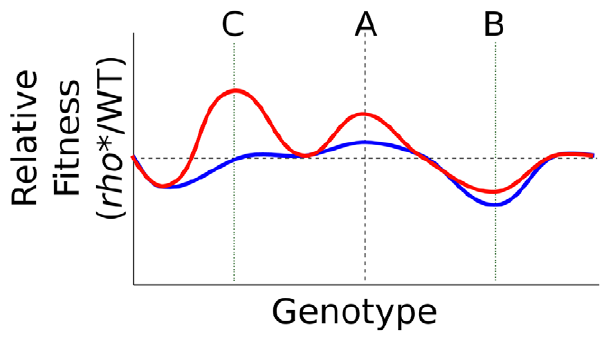
Figure 6. Transformation of the fitness landscape caused by rho *. Shown is a cartoon of the relative fitness of rho * vs. rho WT cells under typical growth conditions (blue) or a stress condition (red), with genotypic variations running along the x axis. Genotype A in each case represents a wild type background (aside from the status at rho ). rho * may directly alter fitness under the stress conditions, interact epistatically with secondary mutations (genotype B, e.g. D visC ), and uncover further beneficial mutations under stress conditions (genotype C, e.g. rpsL* ).